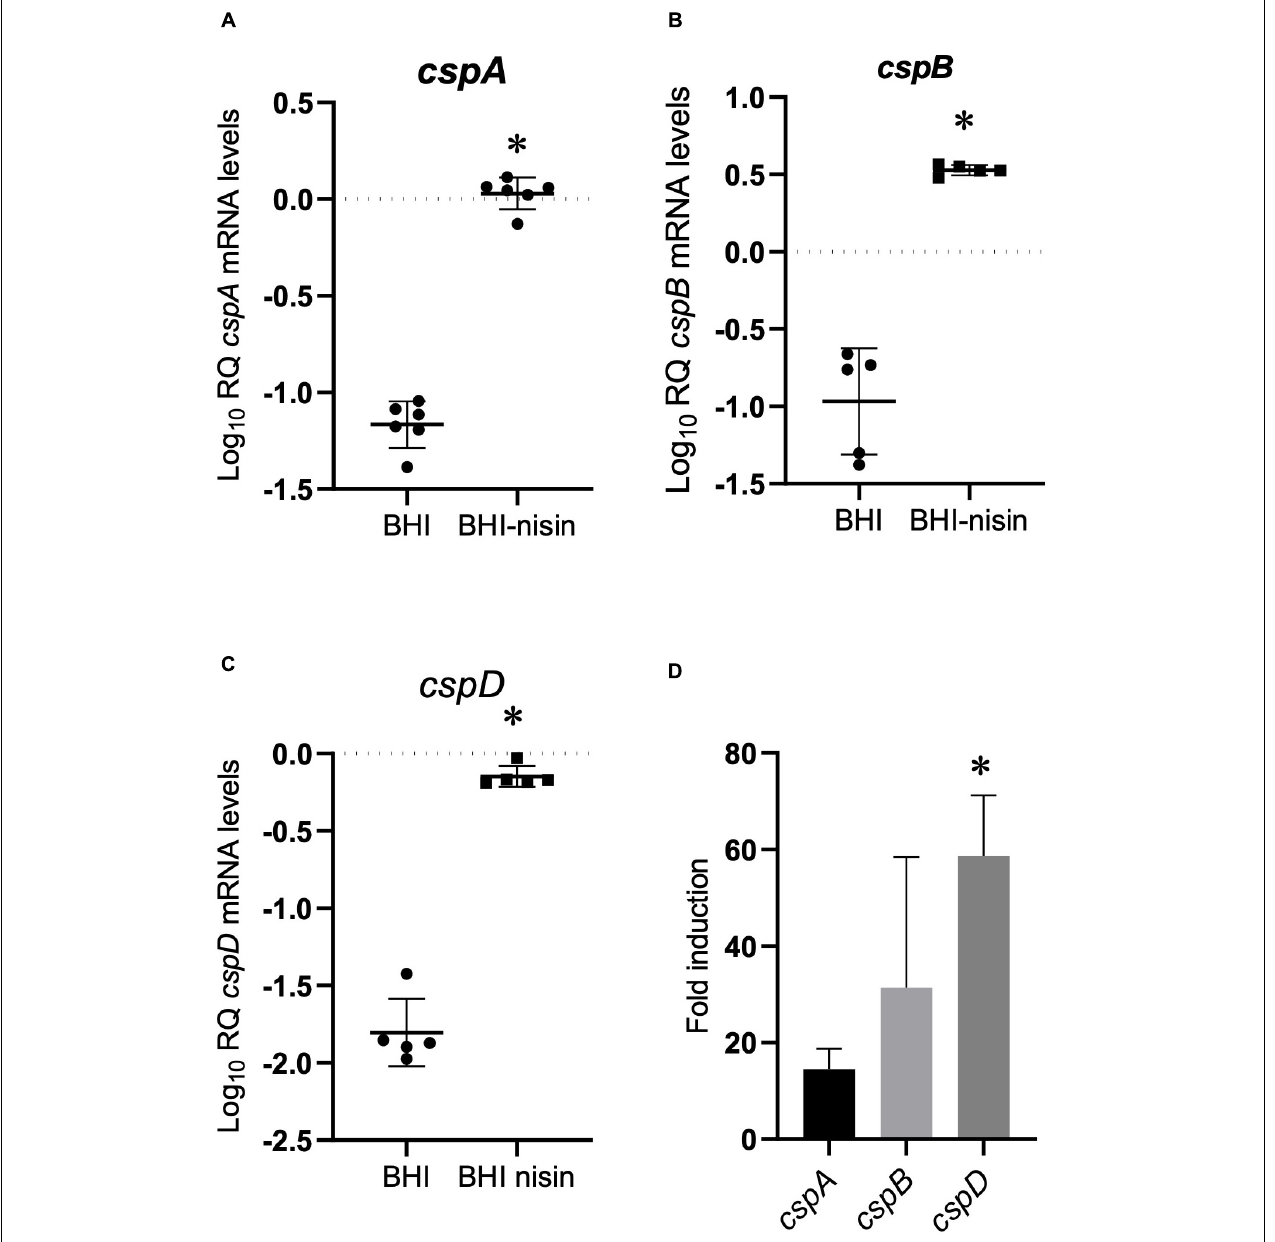
FIGURE 4 | Growth under nisin stress variably induces csp mRNA levels. (A–C) Relative csp mRNA amounts were determined for exponentially growing L. monocytogenes EGDe cells cultivated in normal and nisin (5 ppm)-supplemented BHI. The data are presented as scatter plots showing the mean and SD (number of independent biological replicates = 3). 16S rRNA was used for normalization. (D) Bar charts showing the fold induction of different csp mRNAs relative to the abundance under nisin stress (BHI-nisin) with respect to control levels observed without stress (BHI). ∗ P < 0.05, significant differences in mRNA levels and fold induction identified using the (A–C) t -test for independent samples and (D) Tukey’s post-hoc test pairwise comparison following one-way